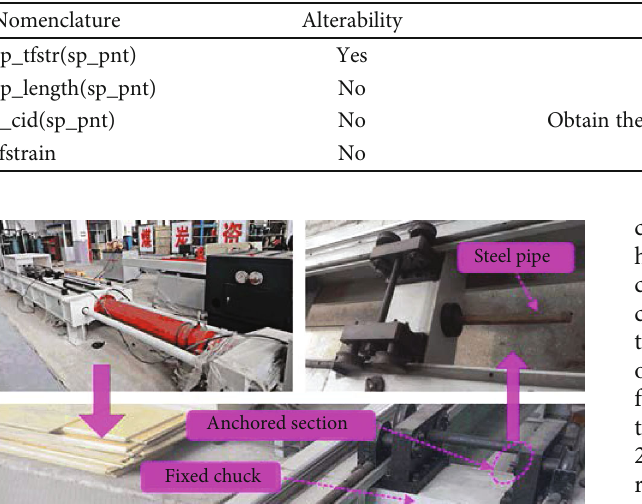
Table 1: Partial embedded functions and commands of pileSEL in FLAC3D.